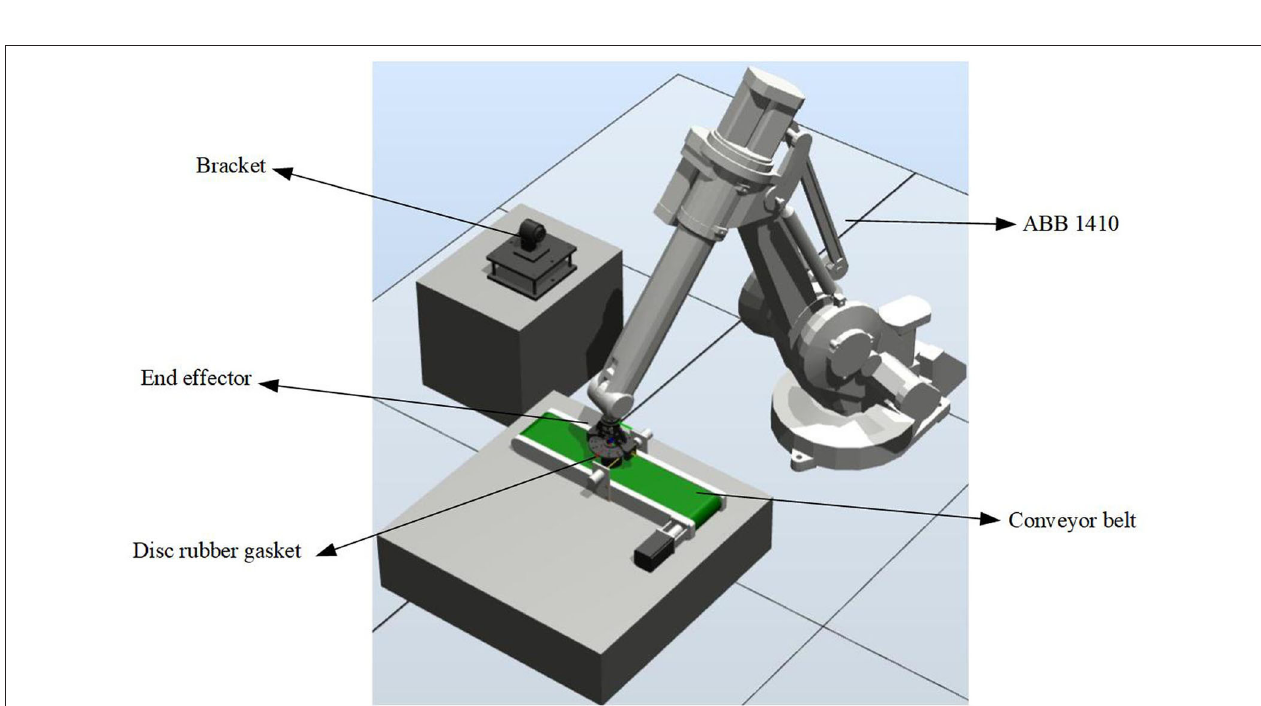
FIGURE 12 | Robot Studio grasp work